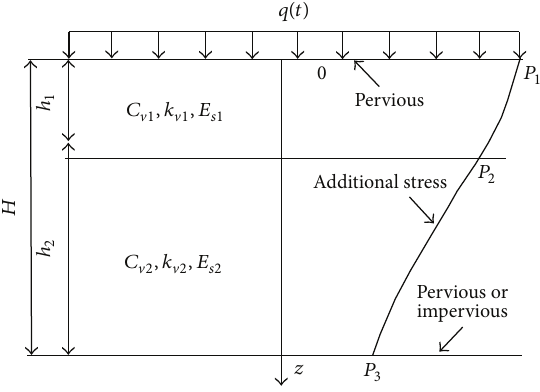
Figure 1: Consolidation problem